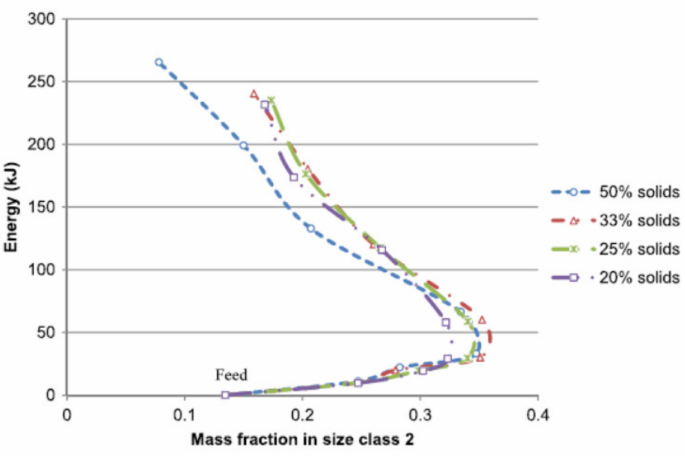
Figure 13. Grinding energy versus m 2